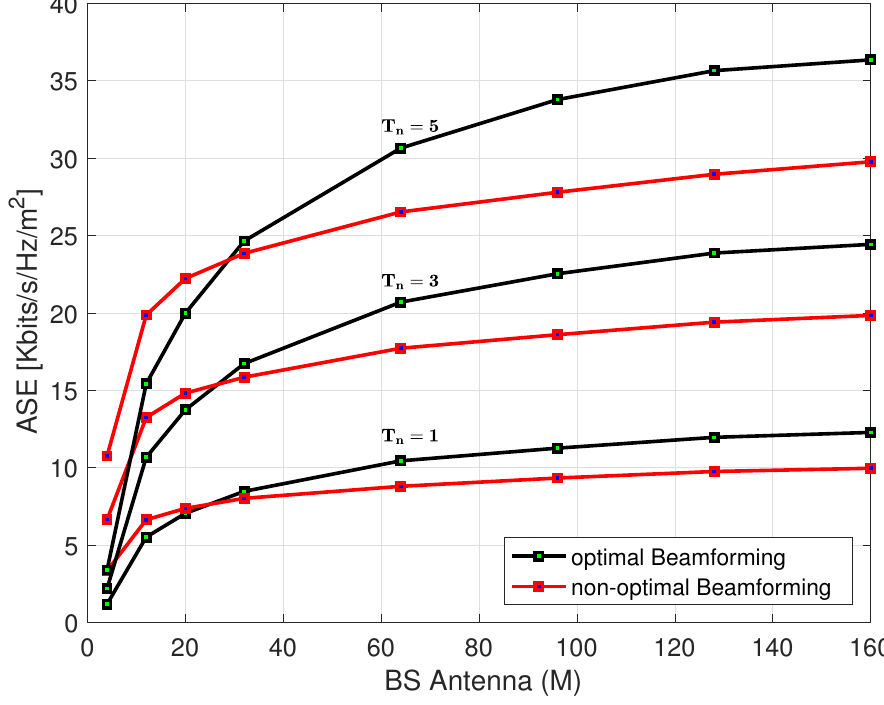
Figure 9. Plot of the Area Spectral Efficiency with BS antenna comparing cases of QoS